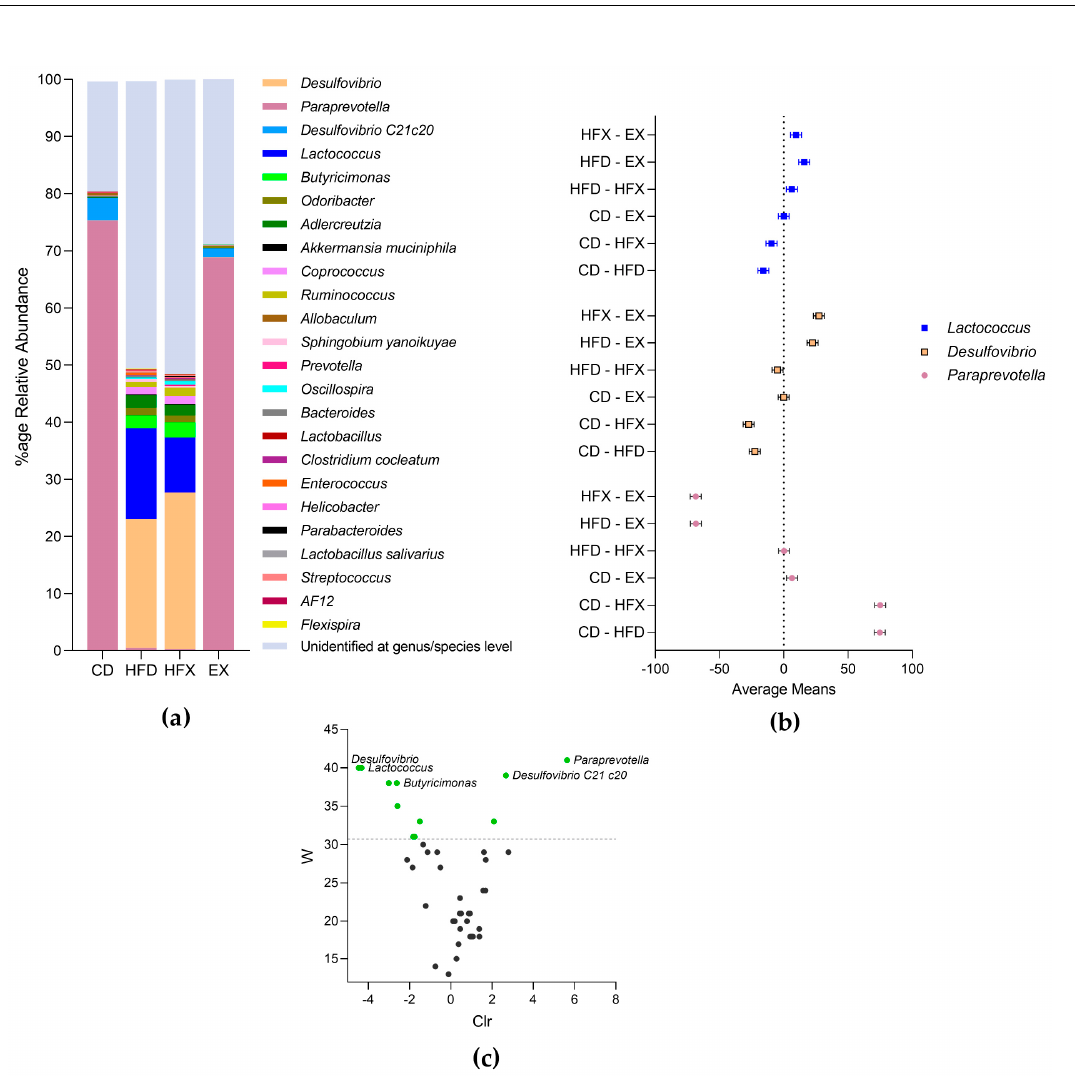
Figure 5. Taxonomic profiling and differentially abundant taxa of the mouse gut microbiota. ( a ) Genus/species level taxonomy. ( b ) Tukey’s multiple comparison analysis of genera (two-way ANOVA) with 95% confidence interval. ( c ) Volcano plot illustrating differentially abundant genera based on diet intervention. The x -axis represents clr (centered log ratio)-transformed mean difference in abundance, of the genus level OTUs, while W represents the frequency of null-hypothesis rejection for a given species. The dotted grey line represents the significance threshold ( p = 0.05).